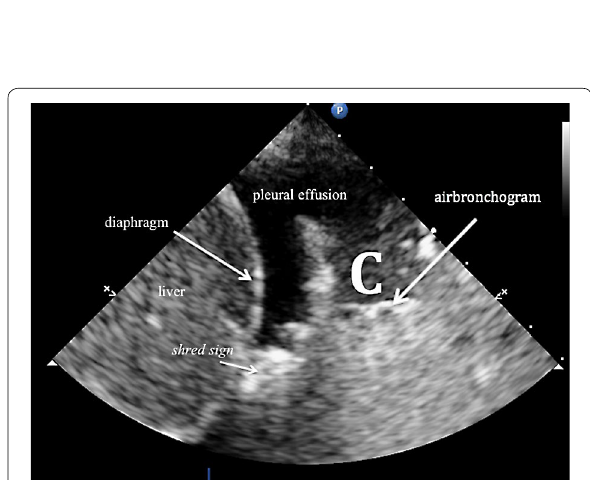
Fig. 5 Posterolateral alveolar and/or pleural